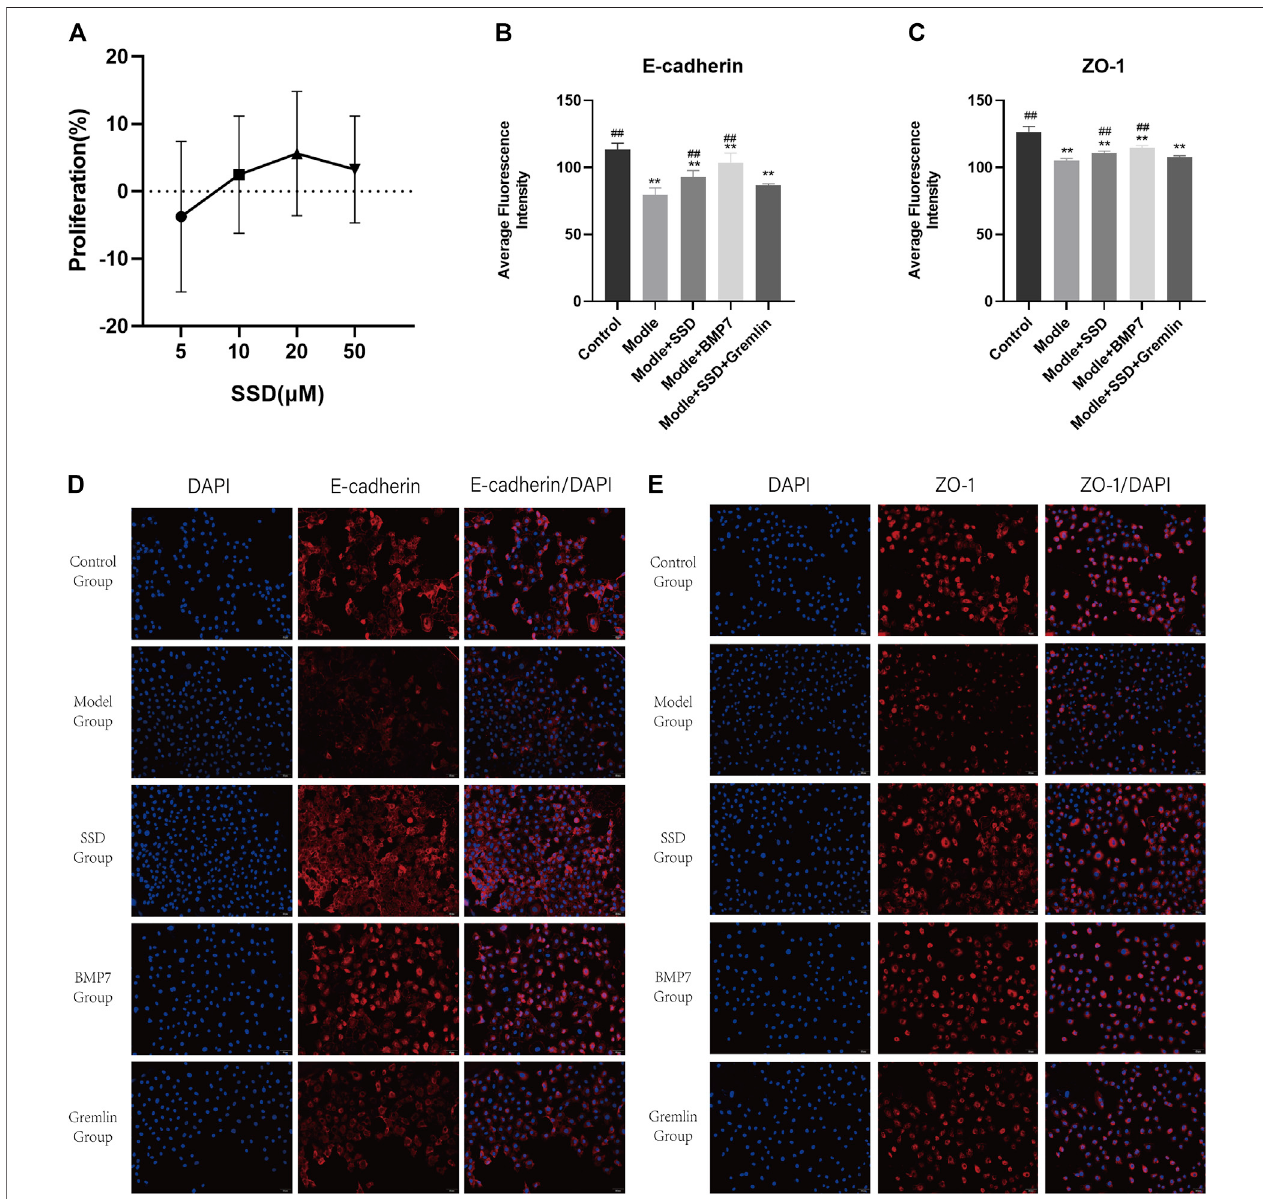
FIGURE 7 | Effects of SSD on HPMC proliferation and expression levels of E-cadherin and ZO-1 detected by immuno fl uorescence in different HPMC groups: (A) MTT experiment: TheproliferationrateofHPMCsinterfered withTGF β 1bydifferentdoses ofSSD(5, 10, 20,50 μ M). (B,C) Semi-quantitativeanalysisofE-cadherinand ZO-1 expression levels detected by immuno fl uorescence. n (cid:2) 5. For comparison with the group M, ## indicates p < 0.01; for comparison with the control group, ** indicates p < 0.01. (D,E) Representativeimmuno fl uorescenceimages(200 × ).ChangesofEMTmarkersinHPMCsafterinterferenceoftheTGF β 1pathwaybySSD, BMP7, and Gremlin1 are